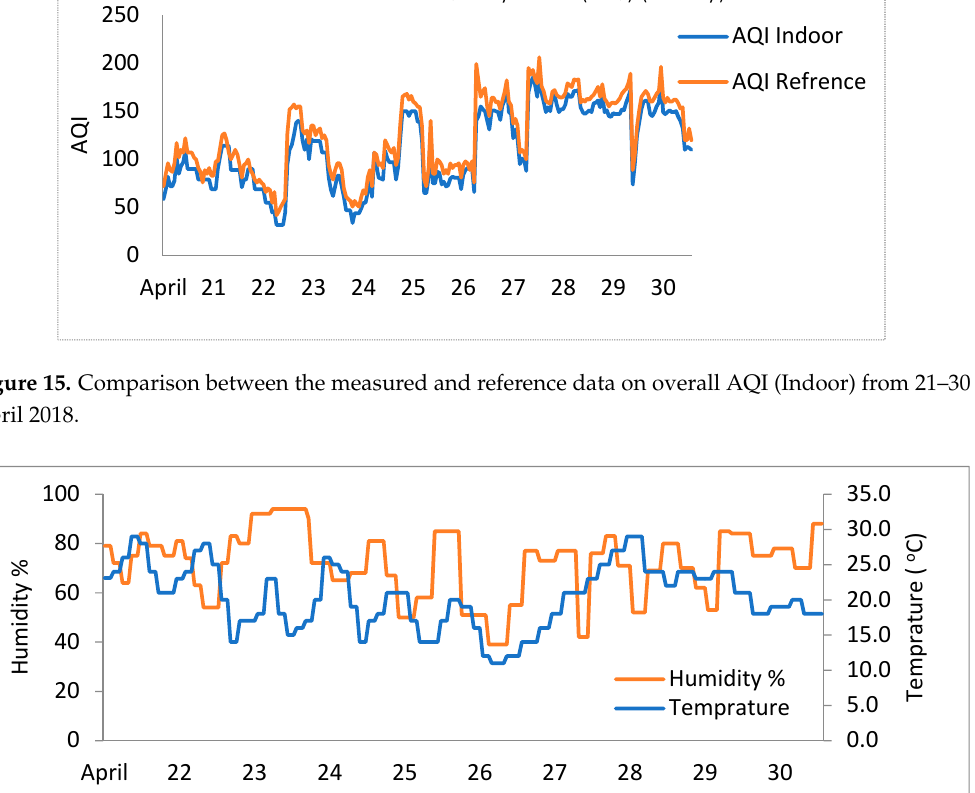
Figure 17. Relative humidity and temperature measurements.